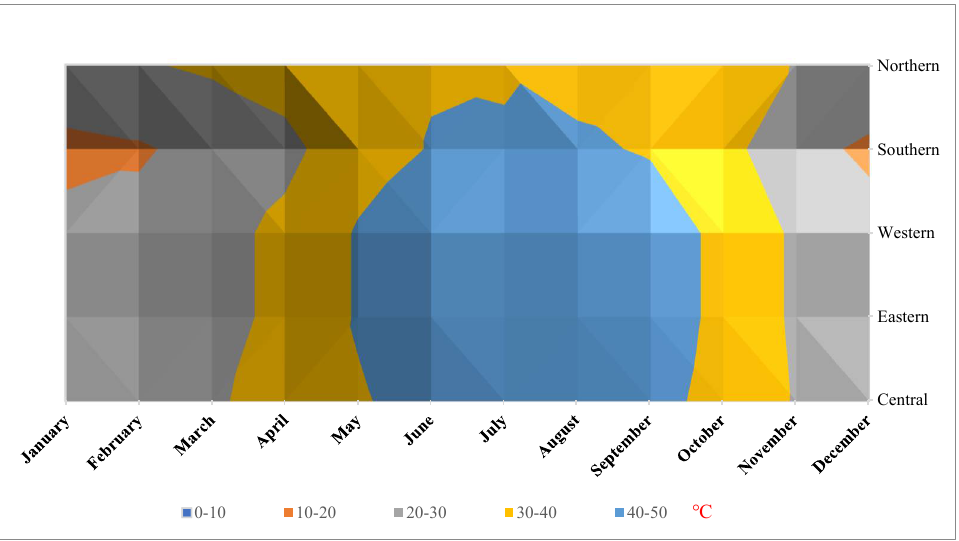
Figure 2. Graphs show the maximum and minimum temperatures ( ◦ C) in the different regions selected for this study: Central Region [Riyadh]; Western Region [Mekka]; Eastern Region [Dammam]; Southern Region [Najran]; and Northern Region [AlJouf]. General Authority for Statistics, GAS,